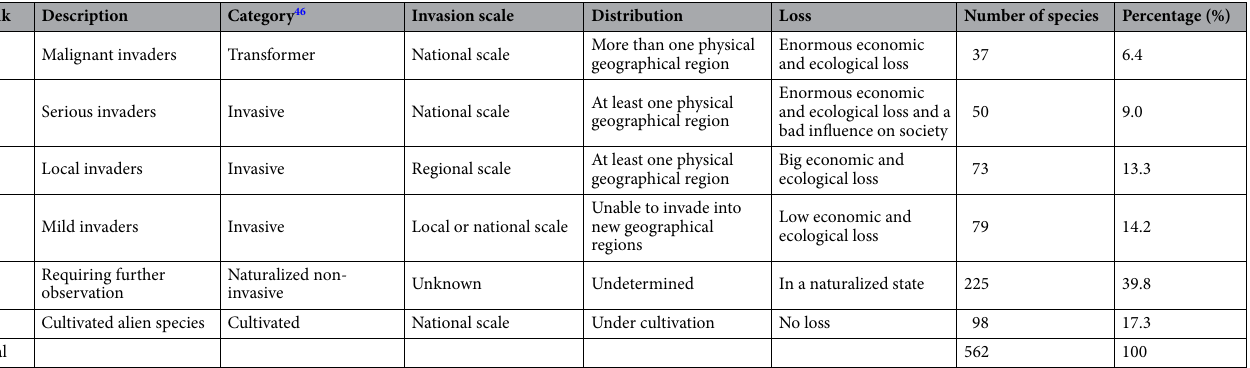
Table 1. Definitions of the six risk ranks and the percentage of alien plant species in China that belonged in each.